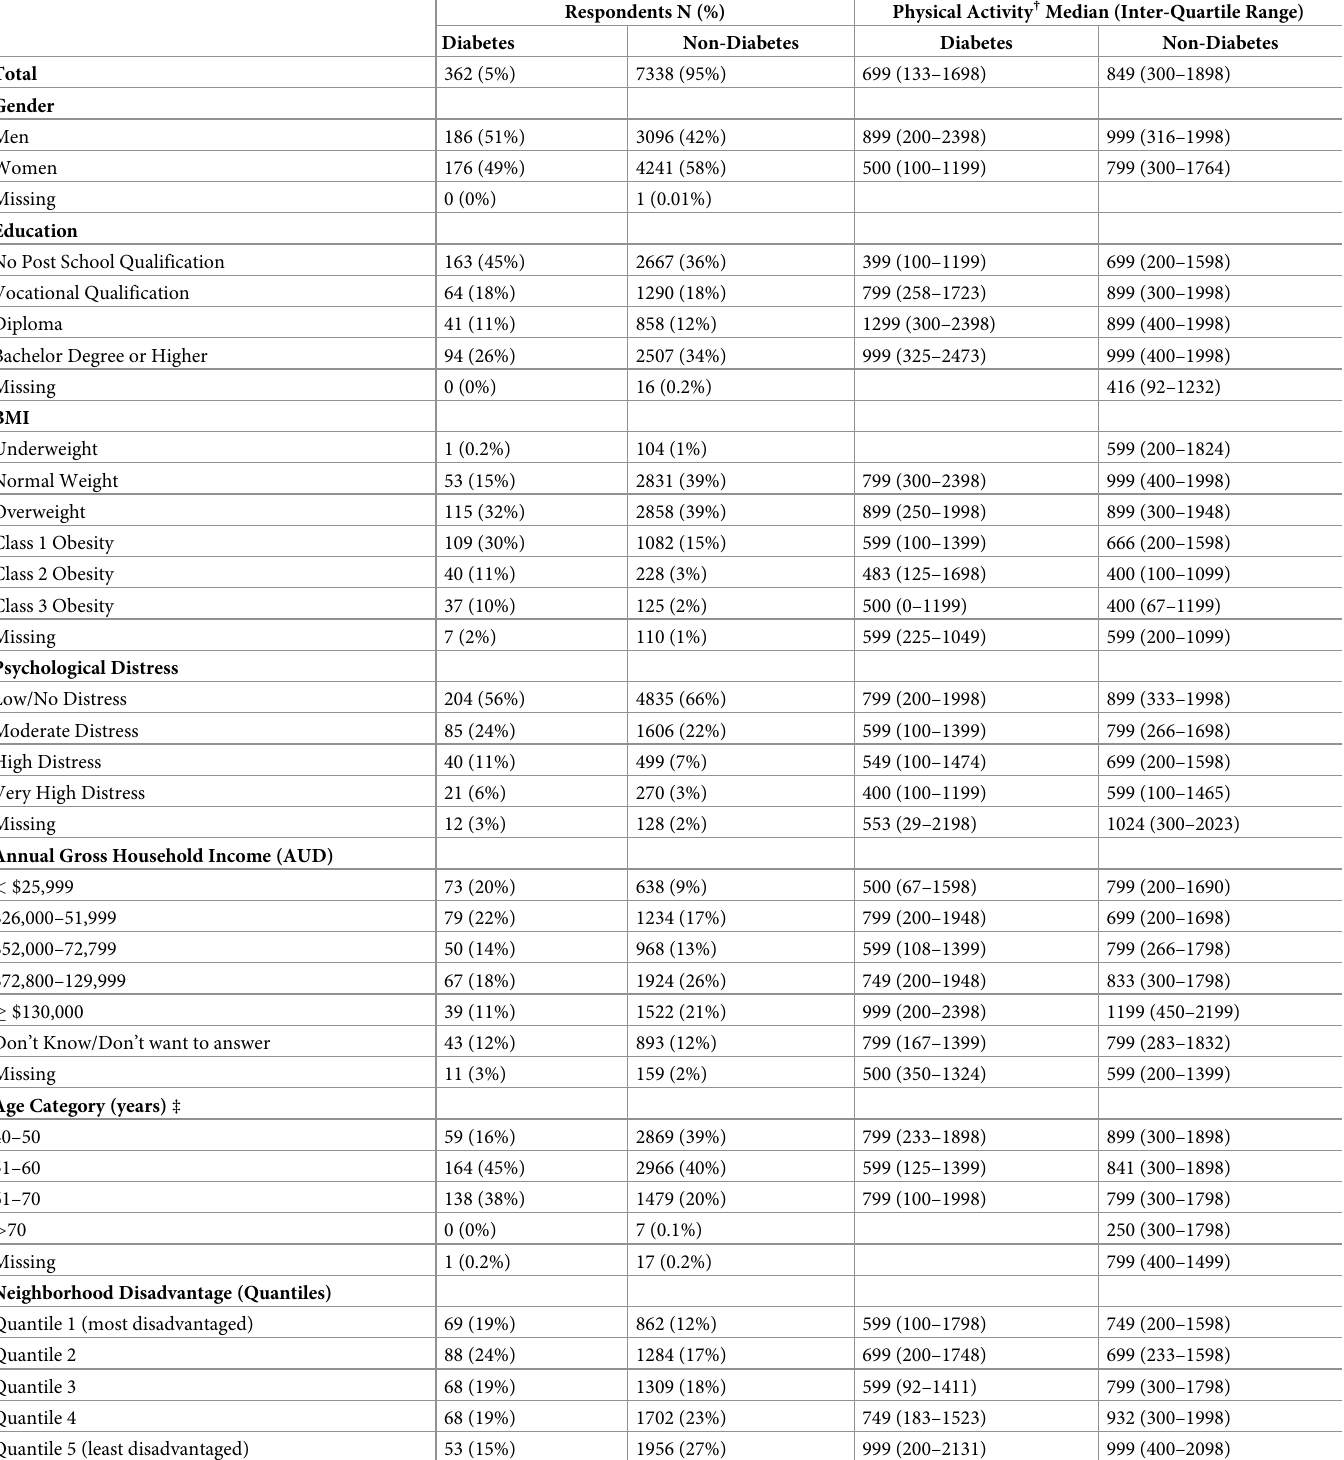
Table 1. Characteristics of the analytic study sample at entry, by diabetes